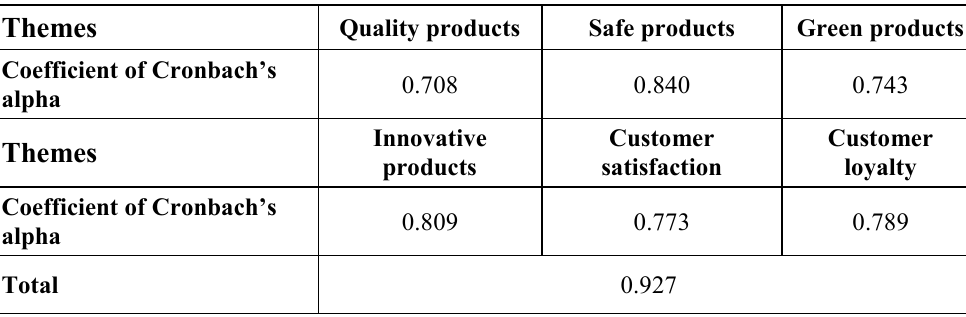
Table 1. Stability Coefficients (Cronbach’s alpha